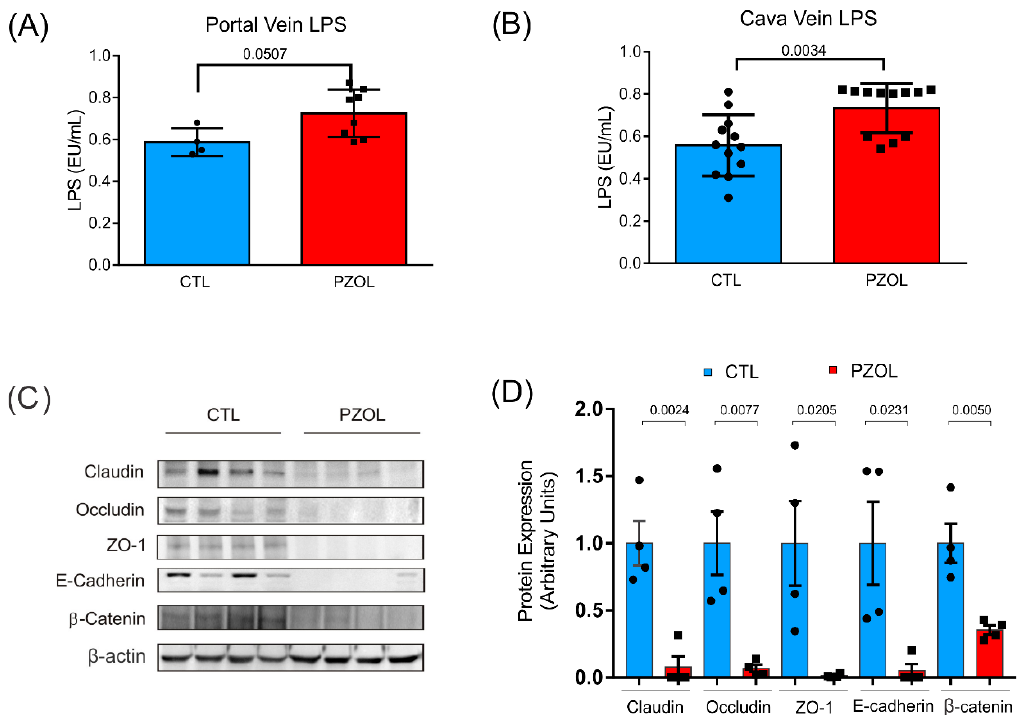
Figure 4. Pantoprazole induced alterations in epithelial barrier integrity in ileum. ( A ) LPS levels in portal vein (CTL: n = 4 and PZOL: n = 8) and ( B ) cava vein (CTL: n = 12 and PZOL: n = 12); ( C ) tissue levels of tight junction proteins (claudin, occludin and ZO-1), and adherens junction proteins (e-cadherin and beta-catenin) and ( D ) quantification of the Western blots (CTL: n = 4 and PZOL: n = 4). Data are expressed as mean ± standard deviation and t -test statistical comparisons.